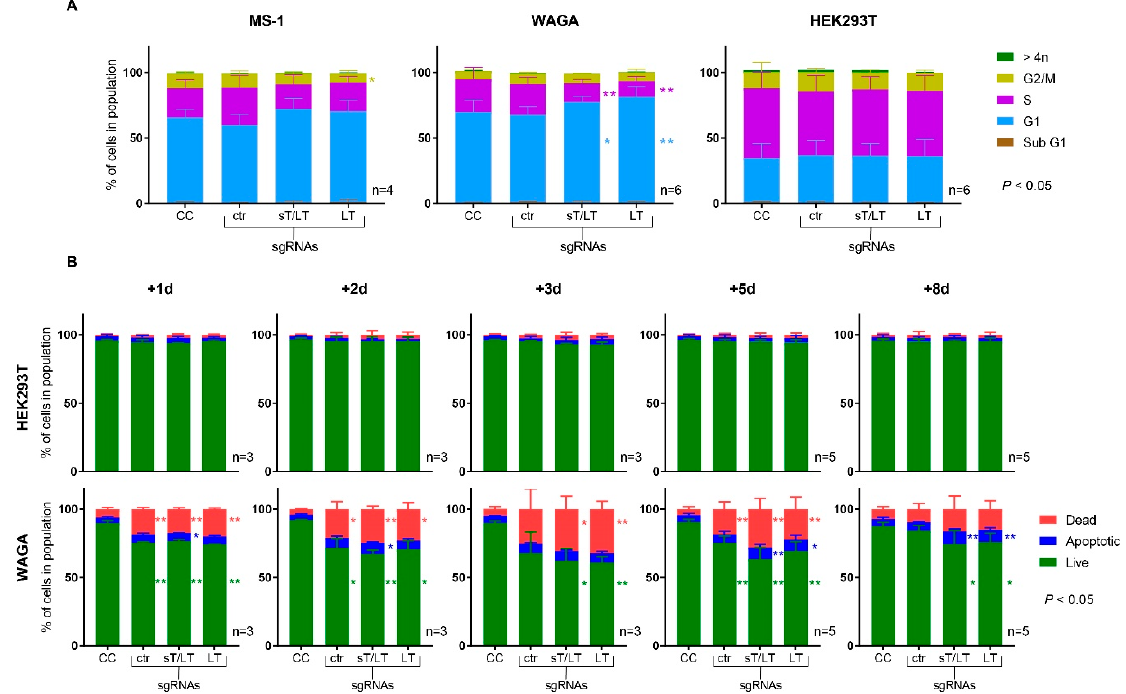
Figure 5. Cell cycle distribution and apoptosis analysis upon CRISPR/Cas9 editing of MCPyV TAs. ( A ) Five days after transfection with the indicated CRISPR/Cas9 constructs (ctr-sgRNA, sT/LT-sgRNA, or LT-sgRNA), cell nuclei were stained with PI to analyze cell cycle distribution. The plots depict the percentage of cells in each phase of the cell cycle; ( B ) Cells were stained for apoptosis analysis (Annexin V-APC / viability dye). According to flow cytometry results, cell fractions were separated